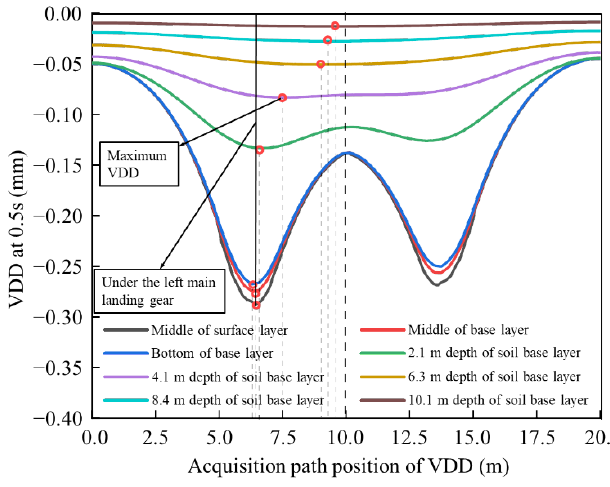
Figure 10. VDDs of different structural layers.